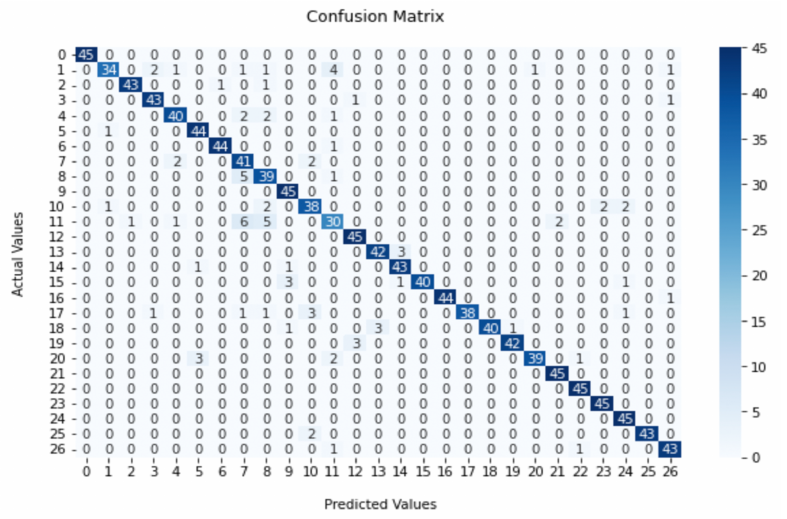
Figure 12. Confusion matrix for CNN-based classification with mel spectrogram and augmented